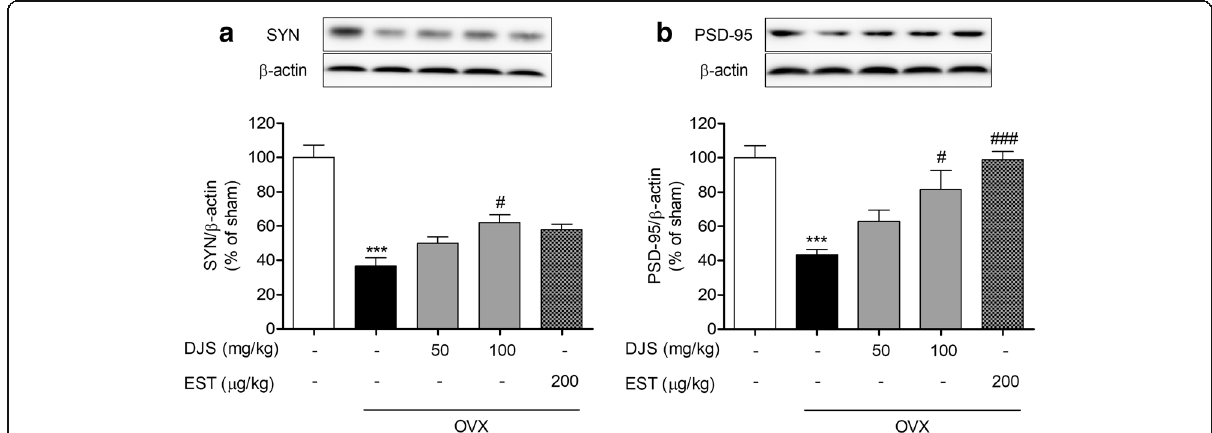
Fig. 4 Effects of DJS on OVX-induced synaptic loss in the mouse hippocampus. Expression of synaptophysin (SYN) and PSD-95 was assessed by Western blot analysis using SYN ( a ) and PSD-95 ( b ) antibodies. ***p < 0.001 compared with the sham group, #p < 0.05 and ###p < 0.001 compared with the OVX